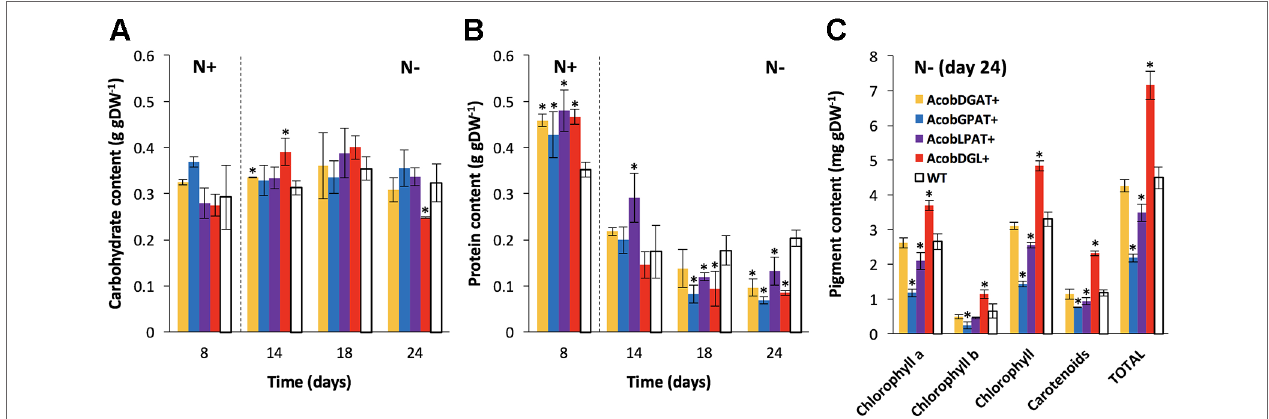
FigUrE 3 | Biochemical composition in N. oleoabundans wild type strain and transformant lines. Carbohydrate (A) , protein (B) , and pigment (C) content in wild type (WT) and transformant lines. Dashed lines indicate the moment at which nitrogen starvation started. Pigment content as determined for all strains at day 24 under nitrogen starvation. Chlorophyll represents the sum of chlorophyll a and chlorophyll b. Total pigments correspond to the sum of total chlorophyll and carotenoids. The data represent the average of n = 3 replicate experiments. Standard deviation bars are shown. Significant difference between wild type strain and transformant lines is indicated at P < 0.05